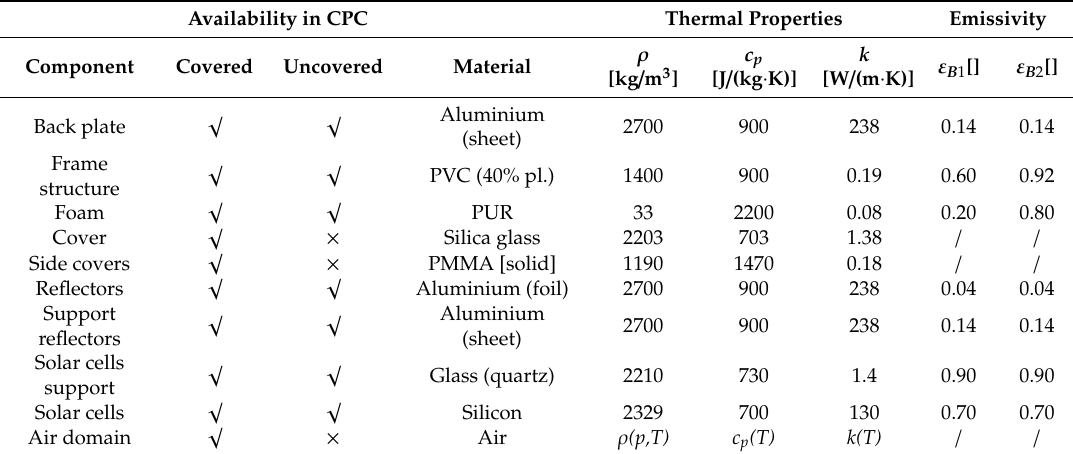
Table 3. Materials’ properties assigned to each domain.